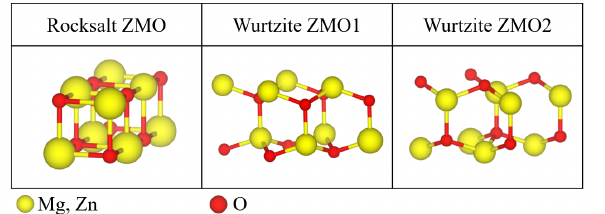
Figure 1. Supercells of 2 × 1 × 1 rocksalt (RS) Mg 1 − x Zn x O and 2 × 2 × 1 wurtzite (WZ) Zn 1 − x Mg x O for ZMO models. The first column is the atomic structure of RS Mg 1 − x Zn x O. The second and third columns are the geometries of WZ Zn 1 − x Mg x O for two different unit cells. The yellow spheres are either magnesium (Mg) or zinc (Zn); the red spheres represent